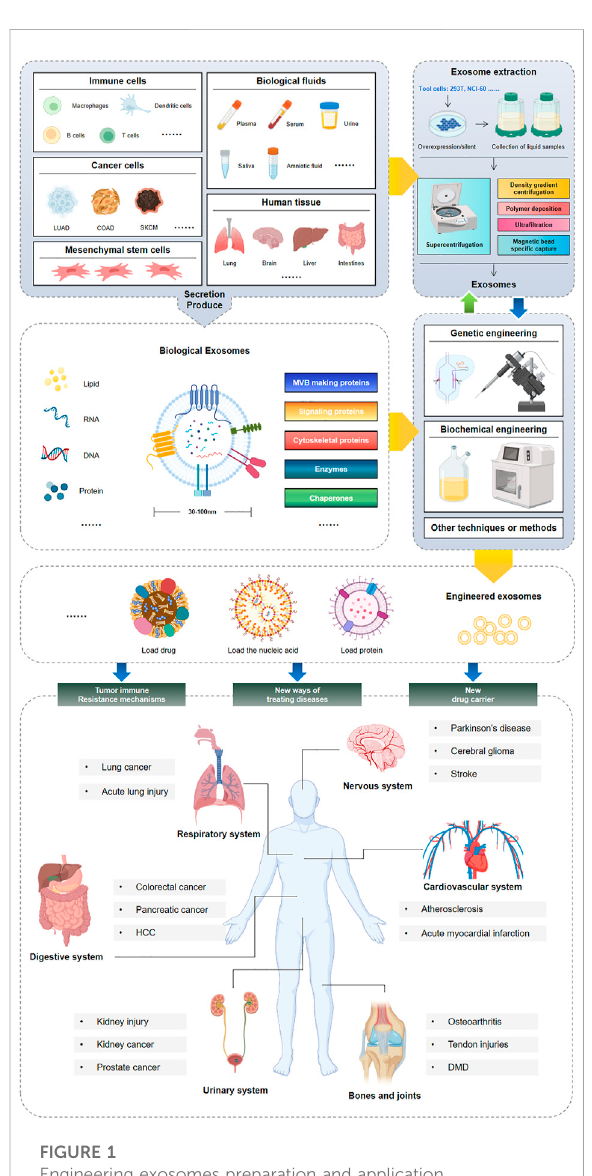
FIGURE 1 Engineering exosomes preparation and